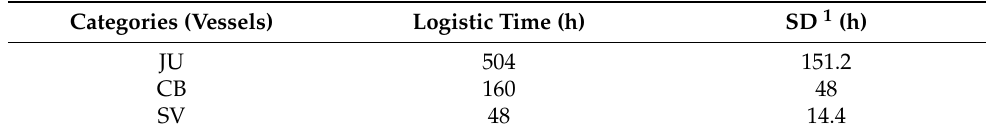
Table 5. Vessels’ logistic times.